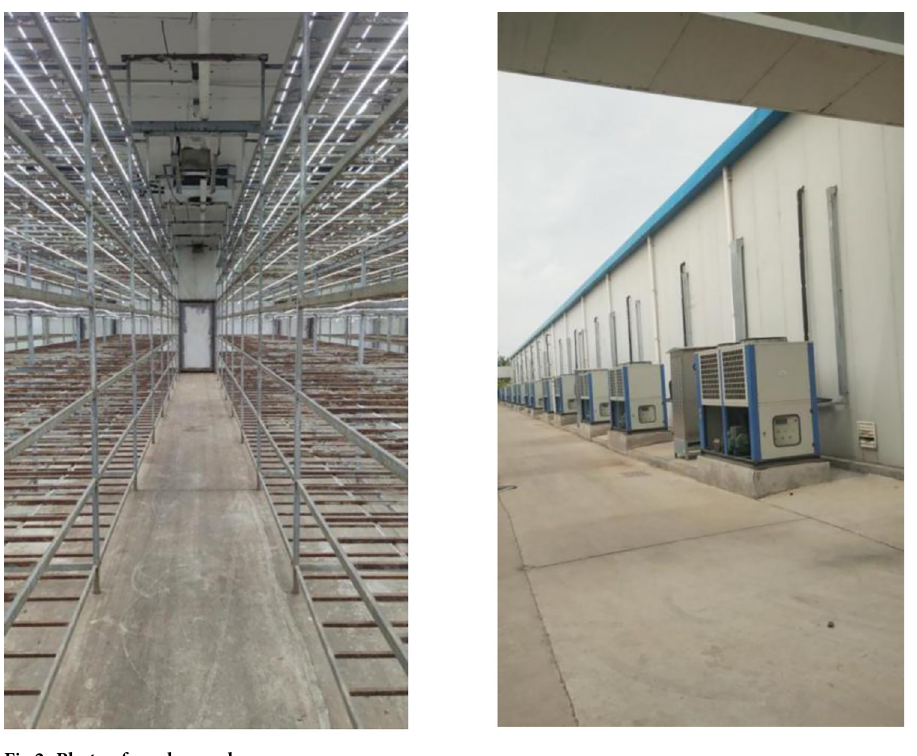
Fig 2. Photo of mushroom house.